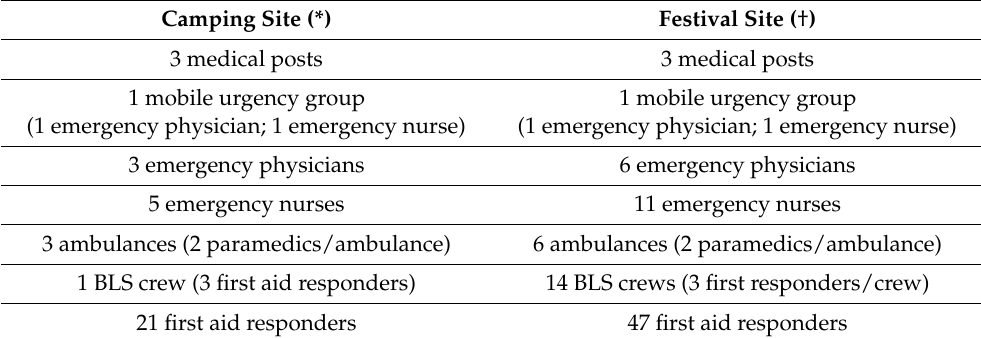
Table 1. Advice on in-event health services staffing by the PRIMA